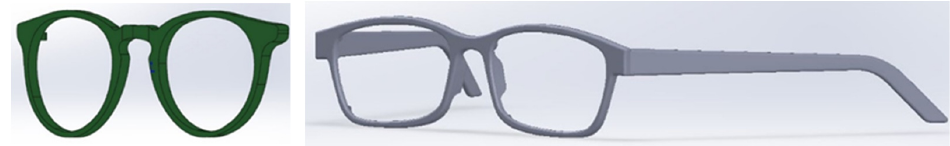
Figure 14. Design 3D models from spectacles frames.